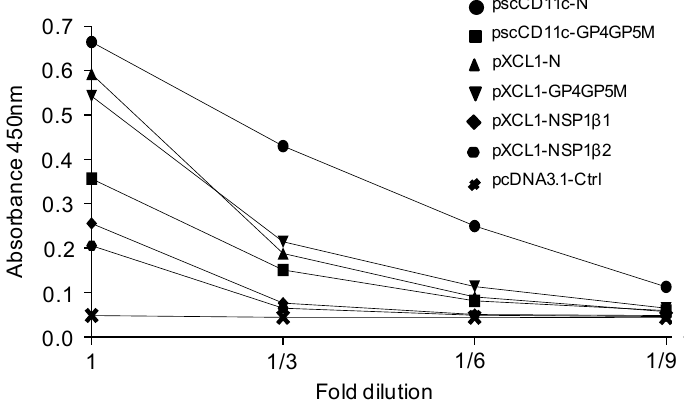
Figure 3. Expression of VB-PRRSV-AGs. The pscCD11c-N, pscCD11c-GP4GP5M, pXCL1-N, pXCL1-GP4GP5M, pXCL1-NSP1 β 1, pXCL1-NSP1 β 2 and pcDNA3.1-ctrl plasmid were transfected in 293T cells. The supernatants were harvested after five-day culture in serum-free medium and assayed in three-fold successive dilutions for VB detection in ELISA using anti-CH3 (capture) and biot-anti-CH3 (detection) antibodies (see material and methods). The absorbance at 450 nm is reported.